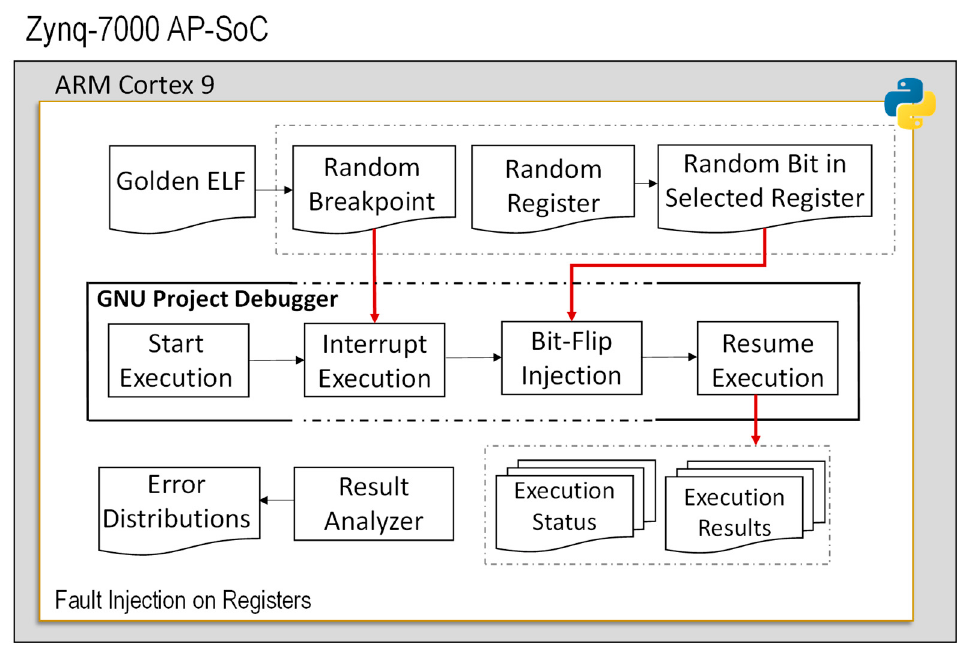
Figure 5. The developed environment for SEU injection on register.